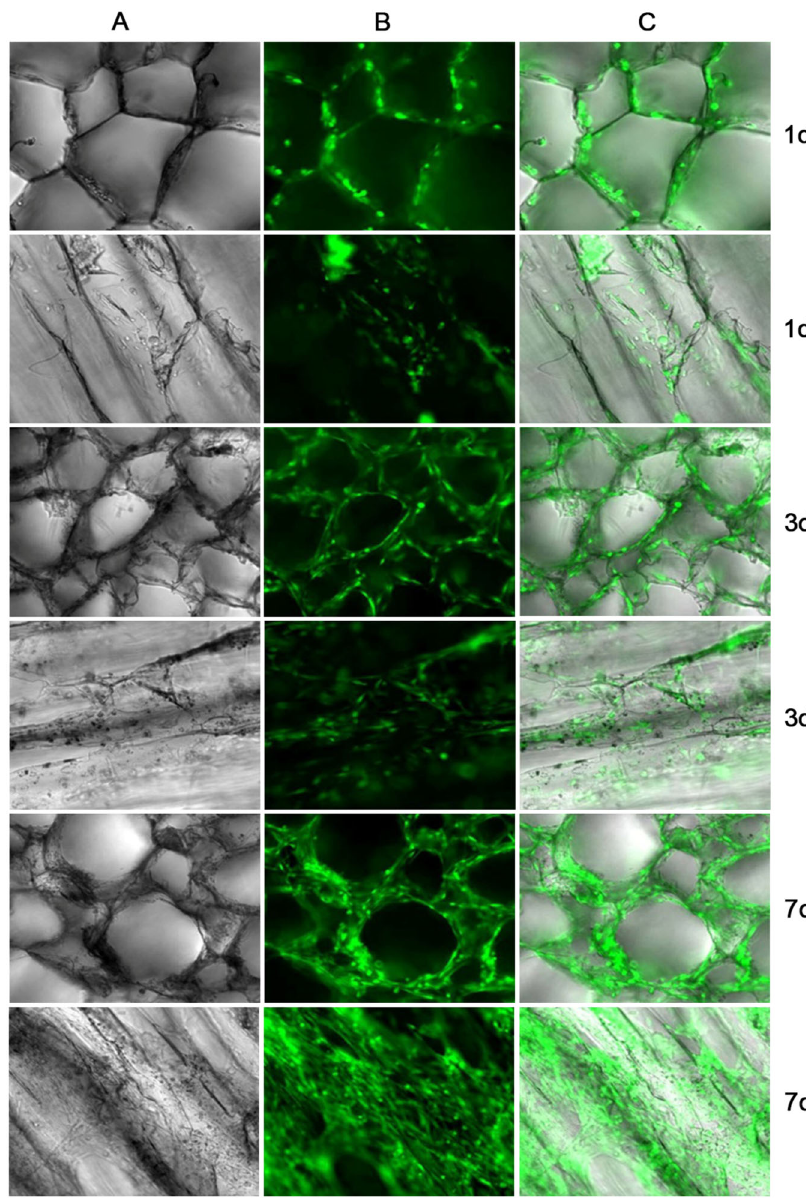
Fig. 3 The image of ADMSCs compatible with the Atelocollagen scaffolds. Columns a – c represents pictures of optical microscope, fl uorescence microscope and merged pictures of a and b . Pictures in Row 1 and 2 are cultured ADMSCs-GFP in the Atelocollagen scaffolds on the 1st day. Pictures in Row 3 and 4 are cultured ADMSCs-GFP in the Atelocollagen scaffolds on the 3rd day. Pictures in Row 5 and 6 are cultured ADMSCs- GFP in the Atelocollagen scaffolds on the 7th